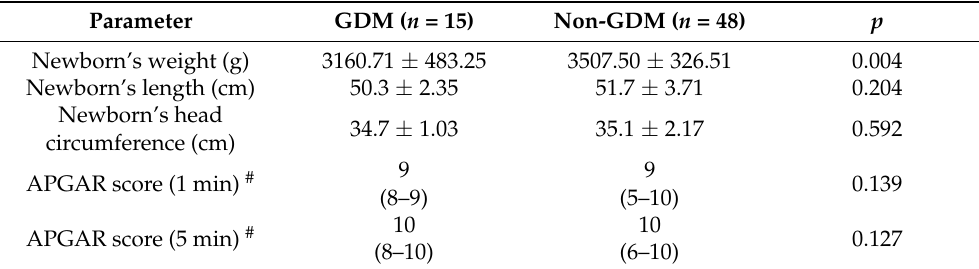
Table 7. Characteristics of the newborns of mothers with and without